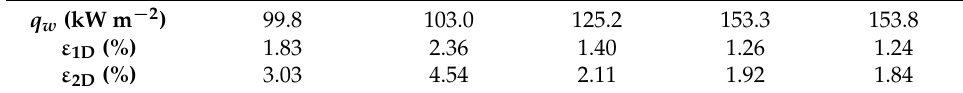
Table 1. The values of the mean relative differences ε 1D and ε 2D for different heat fluxes. q w (kW m − 2